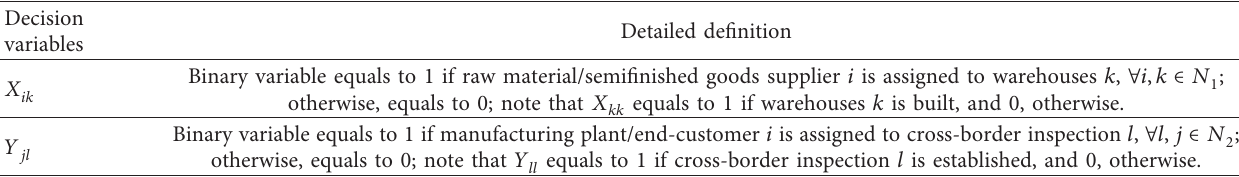
Table 2: Decision variables used in the